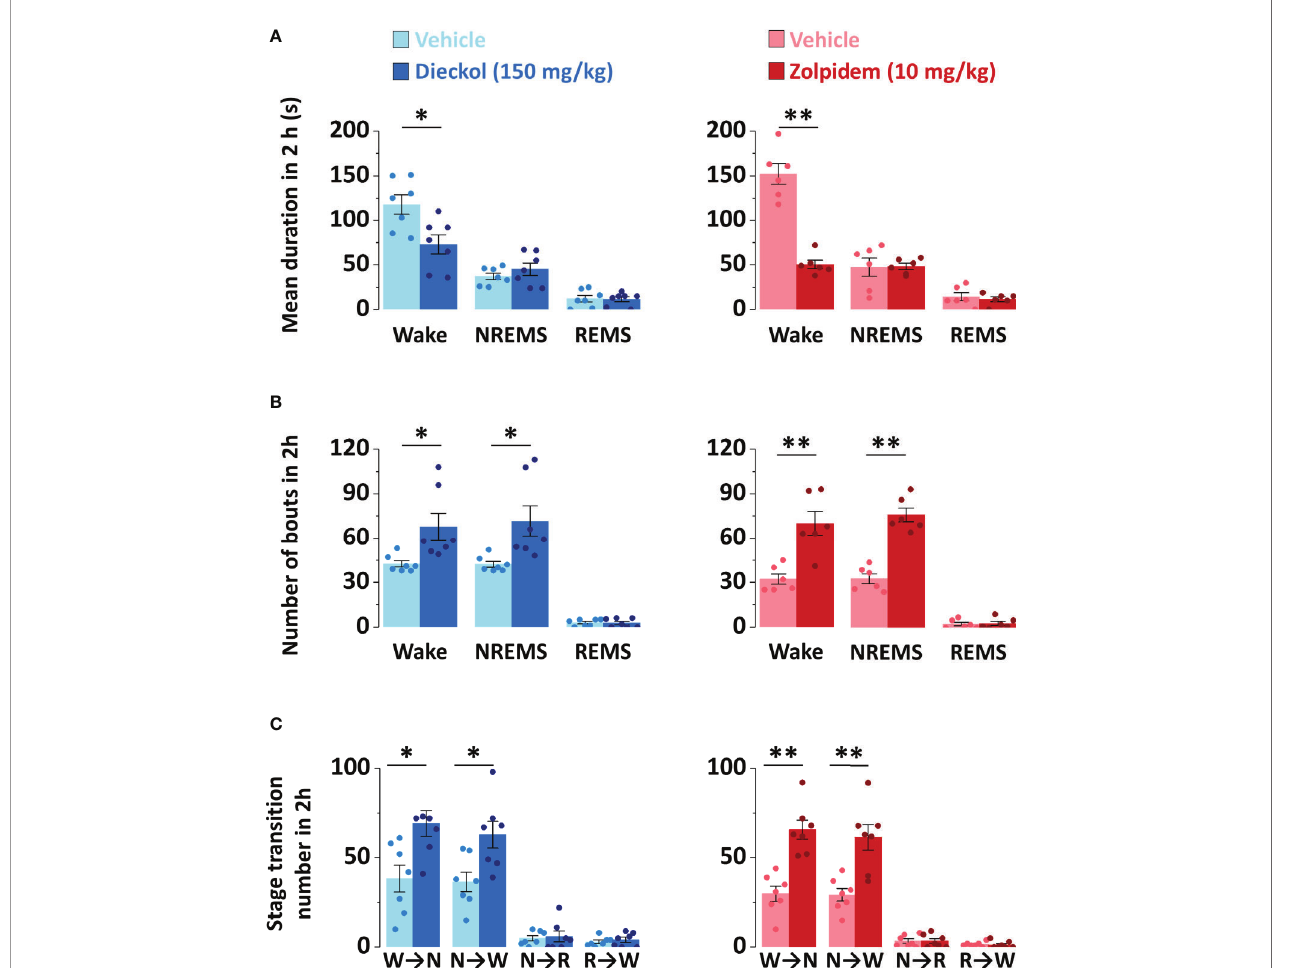
FIGURE 5 | Characteristics of sleep-wake episodes in C57BL/6N mice after oral administration of dieckol and zolpidem. (A) Mean duration and (B) total number of NREMS, REMS, and Wake bouts in a 2 h period after the administration of dieckol and zolpidem. (C) Sleep-wake state transitions during the 2 h following the administration of dieckol and zolpidem. Light and dark bars indicate the baseline day (vehicle administration) and experimental day (dieckol or zolpidem administration), respectively. Each column represents the mean ± SEM (n = 6 – 7) with data points. * p < 0.05 and ** p < 0.01, signi fi cant difference compared to the vehicle (paired Student ’ s t -test). EEG, electroencephalogram; EMG, electromyogram; NREMS (or N), non-rapid eye movement sleep; REMS (or R), rapid eye movement sleep; Wake (or W),